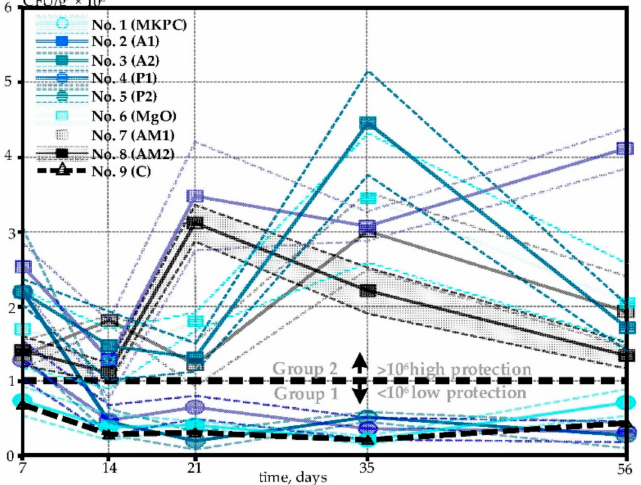
Figure 6. Comparison of the bacterial viability results in concrete specimens produced of differently coated bacteria-embedded expanded clay particles. Solid lines indicate the average values, whereas shaded areas refer to the 95% confidence intervals.